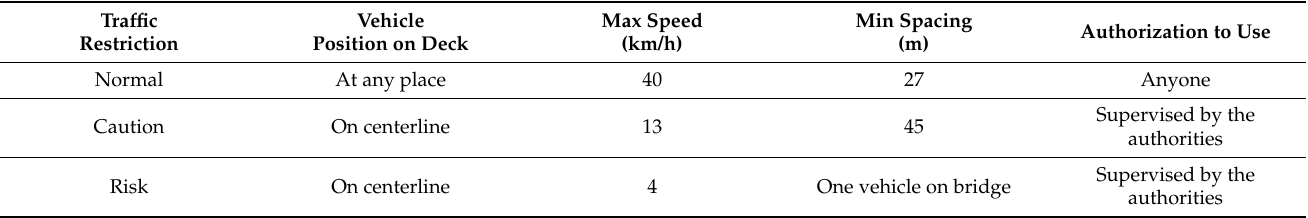
Table 5. Bailey bridge cross restrictions.